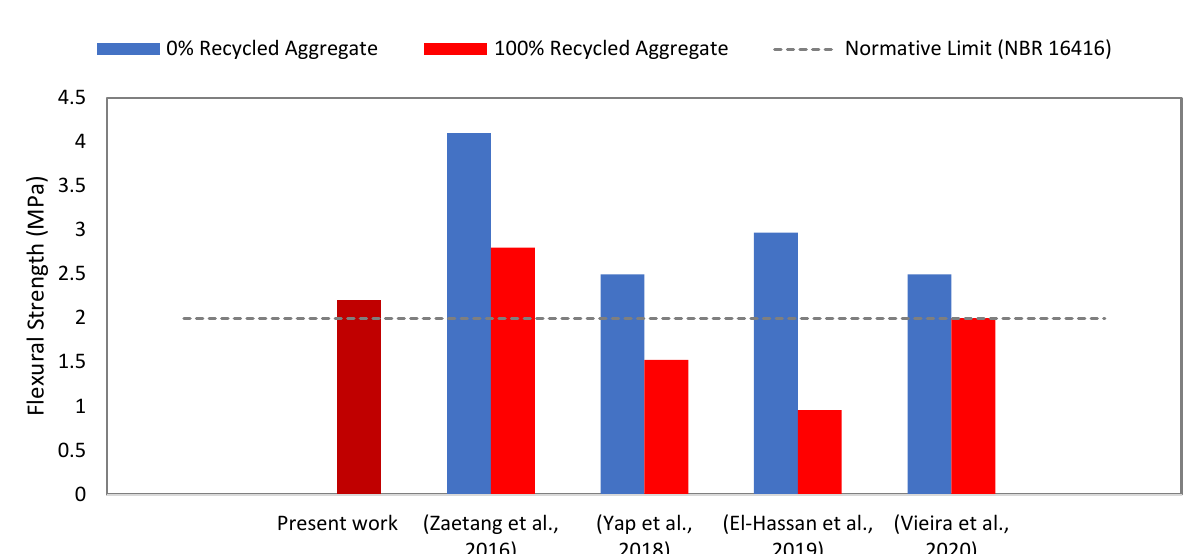
Figure 14. Comparison between the flexural strength values obtained in this study and in the literature.